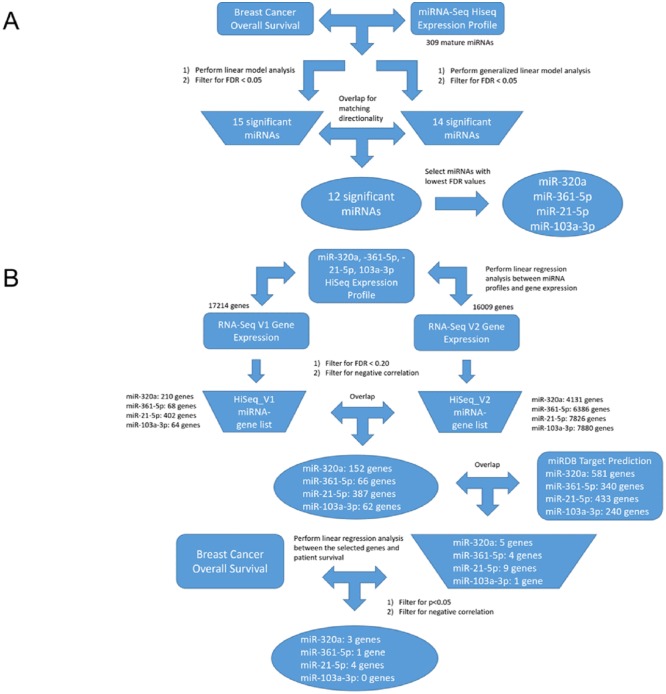
Selection pipeline for miRNAs of interest and finding miRNA-gene interactions in TCGA.A) Selection pipeline to identify clinically relevant miRNAs in breast cancer. Expression data for miRNA and overall survival data (rectangular shapes) were obtained from TCGA breast cancer dataset. Intermediate lists (trapezoid shapes) and findings (oval shapes) derived from our TCGA analysis. B) Selection pipeline to discover possible miRNA-gene interactions. Data retrieved from other sources (rectangular shapes) were obtained from TCGA or miRDB. Intermediate lists (trapezoid shapes) and findings (oval shapes) derived from our analysis.